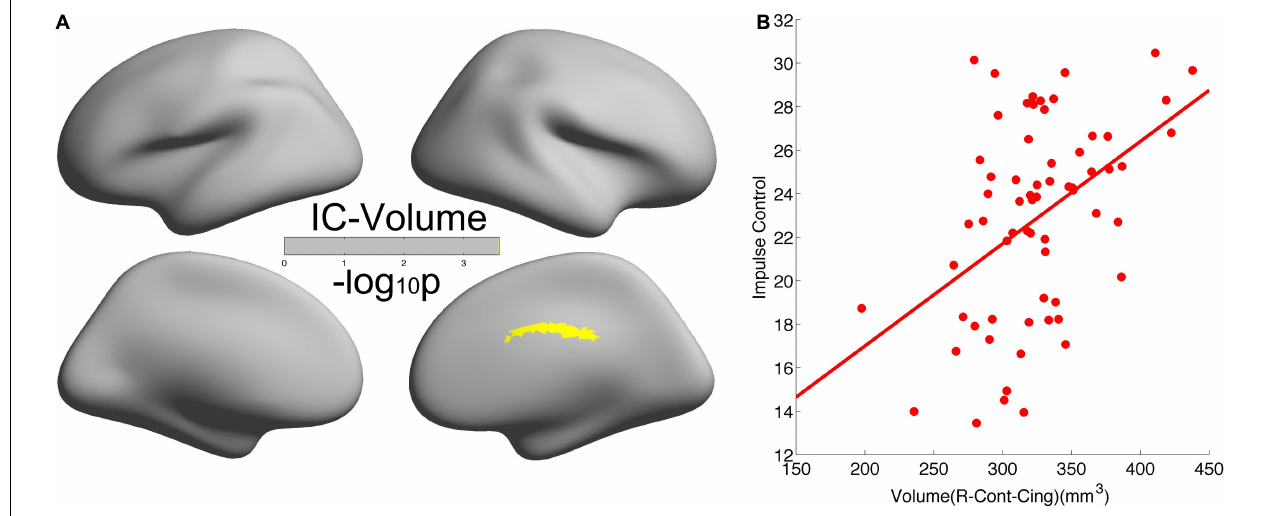
FIGURE 3 | Significant positive correlation of cortical volume in the right cingulate with self-control. (A) Brain regions with significant correlations between cortical volume and self-control. (B) Scatter of the positive